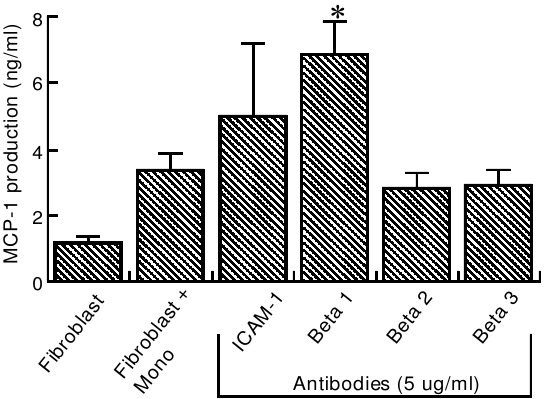
FIG. 6. Blockade of adhesion pathways do not alter produc- tion of MCP-1 production during fibroblast–monocyte inter- action. Monoclonal antibodies to specific adhesion mole- cules or integrins were added to fibroblast–monocyte co-culture at time 0 at a concentration of 5 m g/ml. After 24h of co-culture the culture supernatant was harvested and MCP-1 was measured using a specific ELISA. Data repre- sents mean ± SE of three repeat experiments. * P